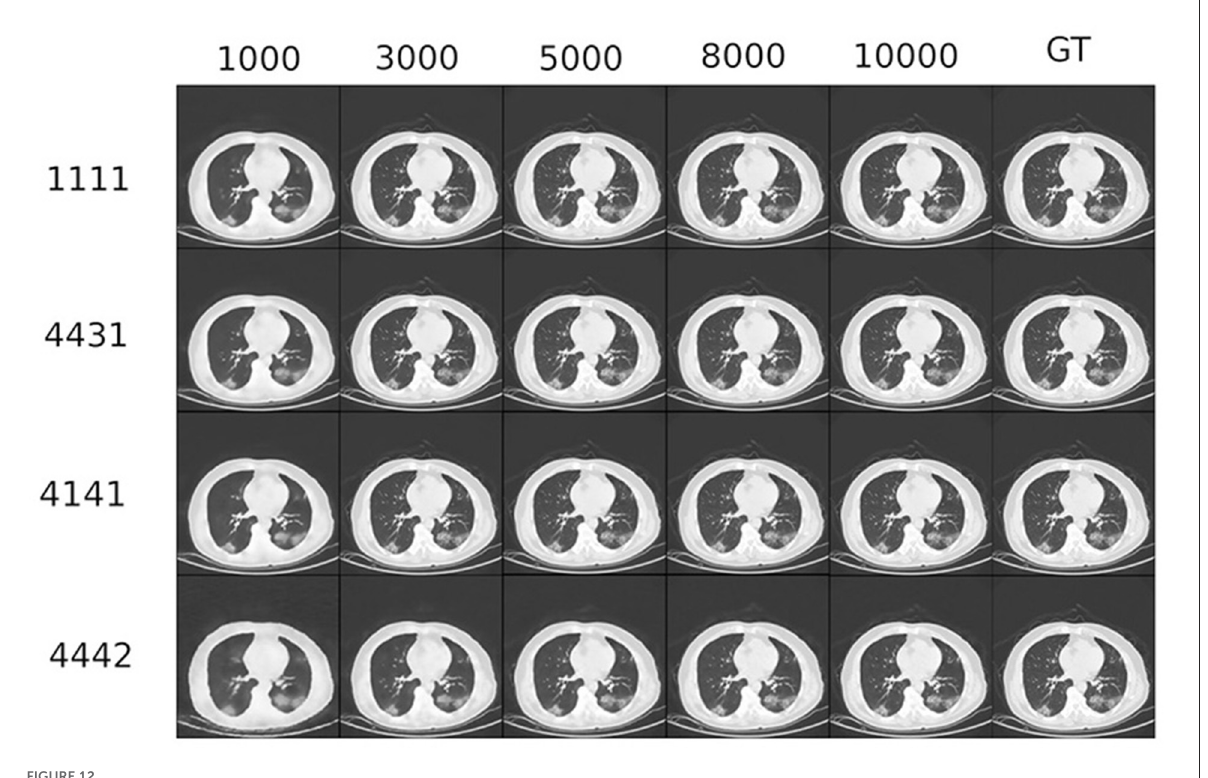
FIGURE12 Reconstruction in different epochs for CT real